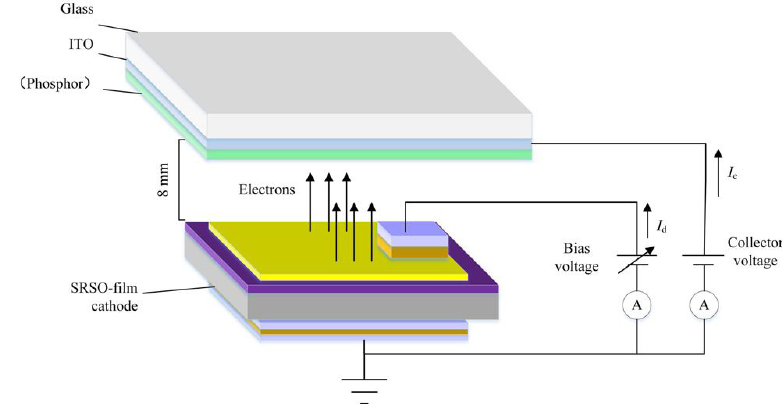
Figure 2. Experimental setup for the measurement of electron emission properties of SRSO-film